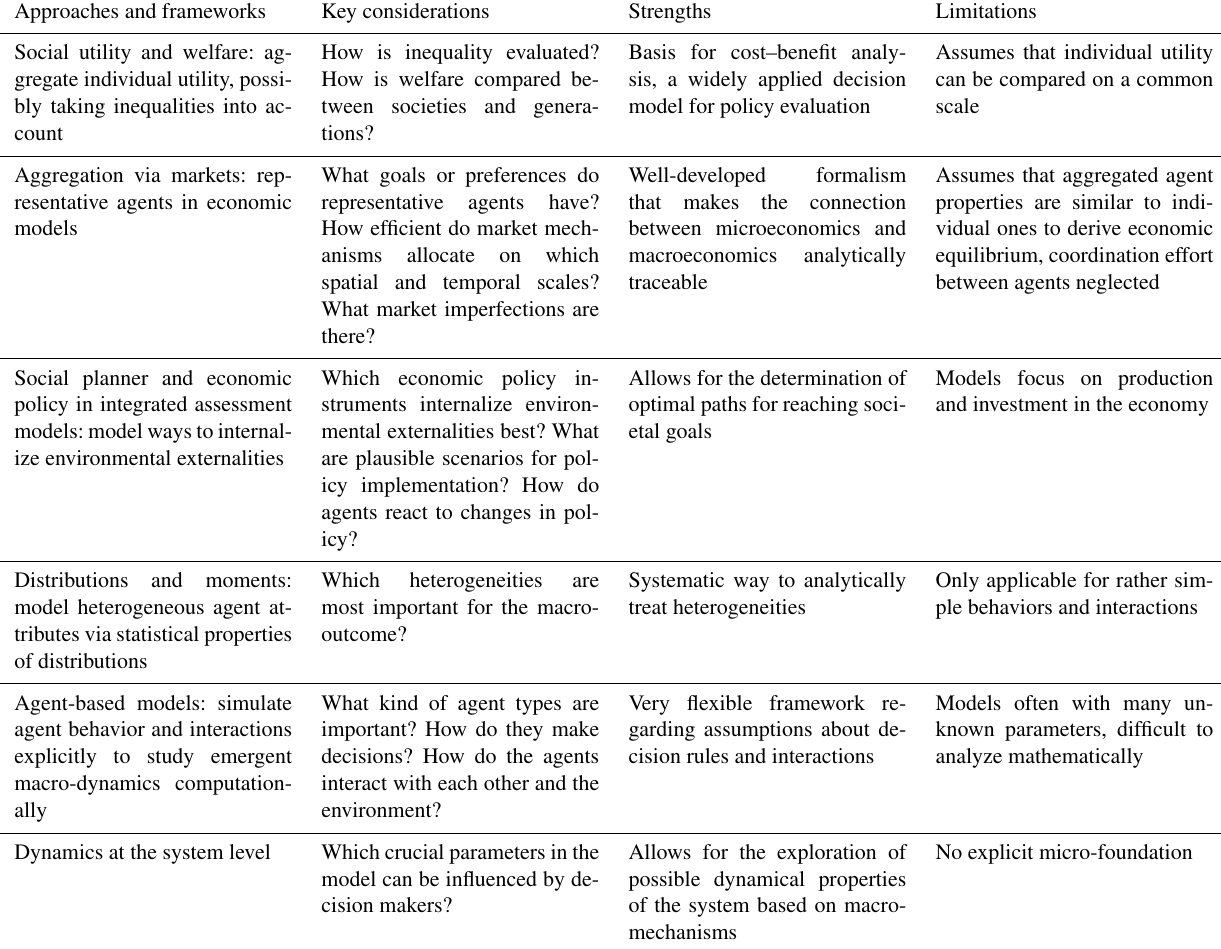
Table 4. Summary table for aggregation and system-level descriptions. Approaches and